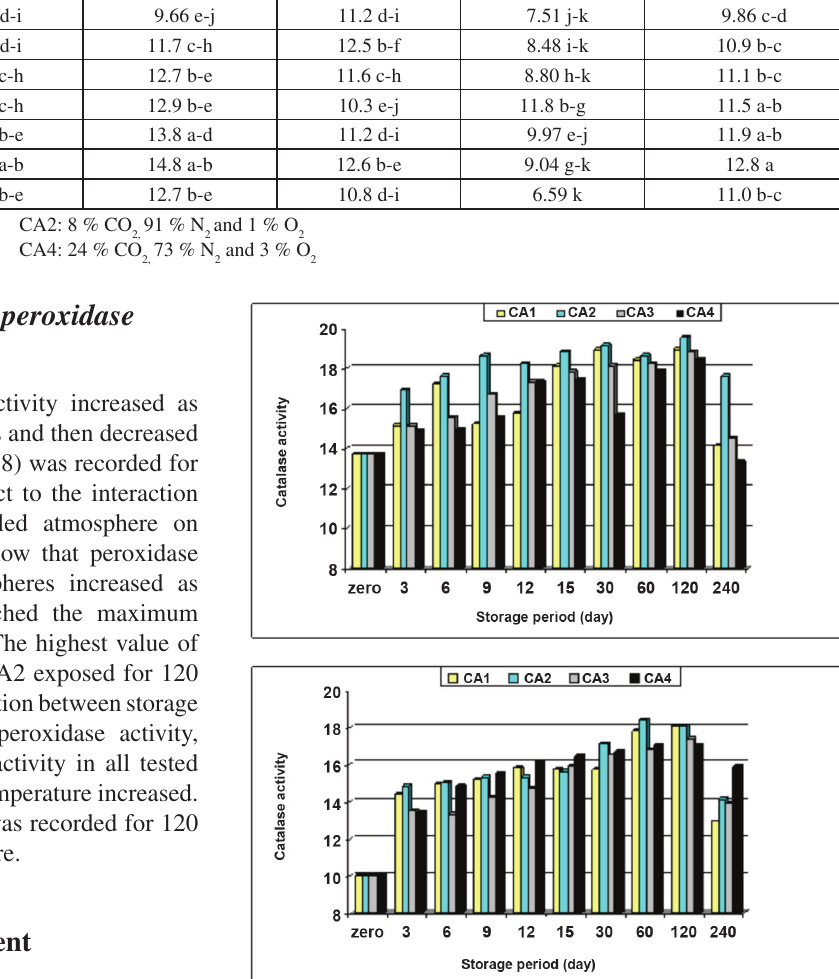
Fig. 5: Effect of the interaction between storage temperature (A, room temperature and B, cold temperature), controlled atmosphere and exposure period on peroxidase activity of onion seeds stored for 12 months. For more details about CA1 to CA4: